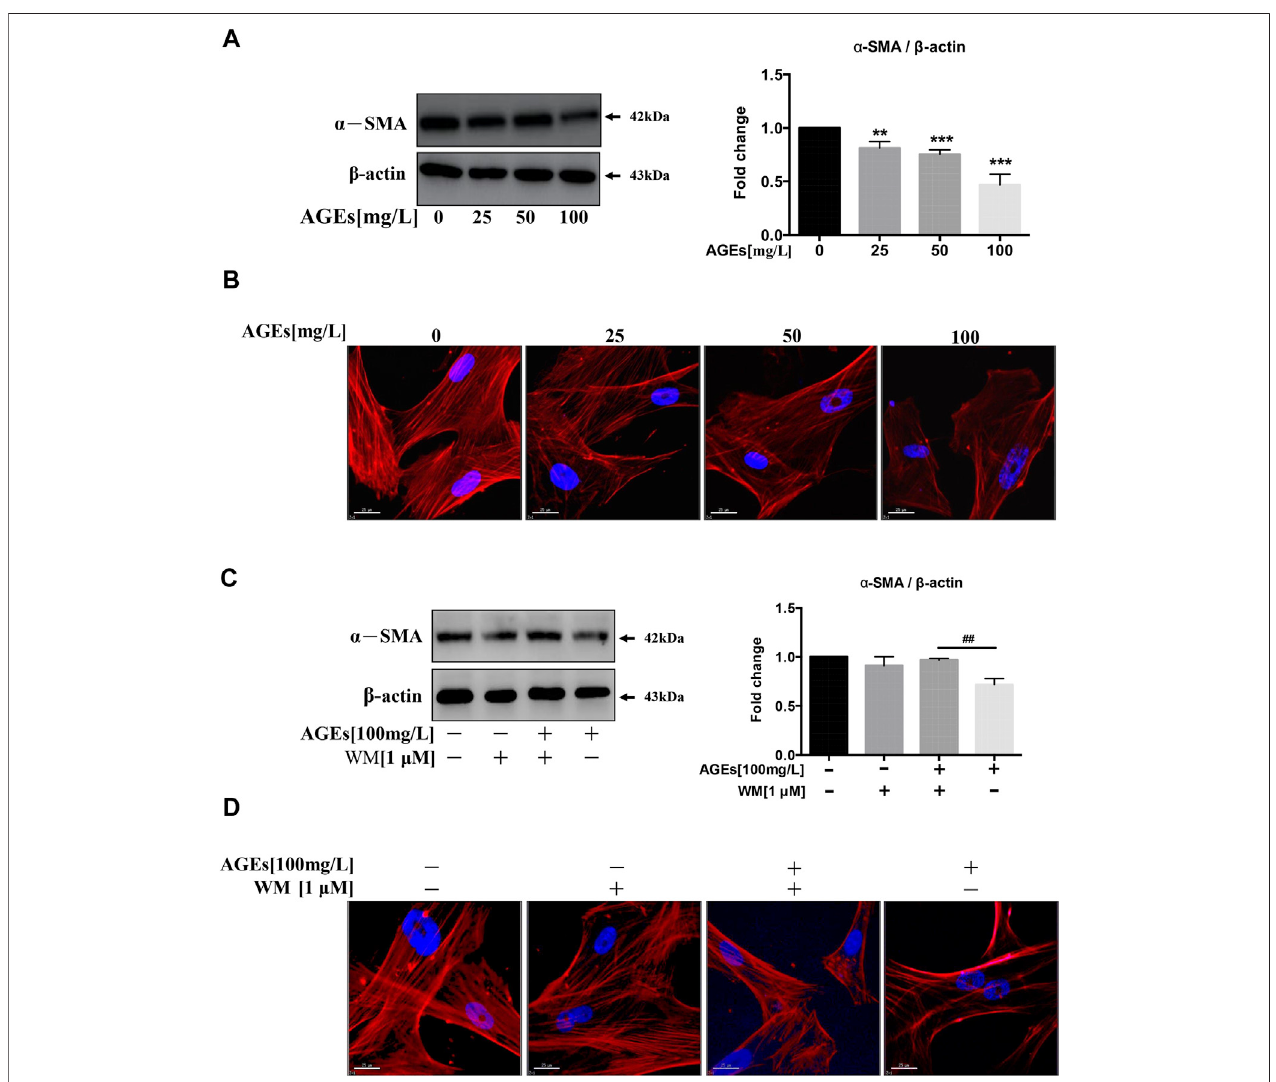
FIGURE5| WMsuppressesphenotypicswitchinginAGEs-treatedHASMCs.CellsweretreatedwithAGEsfor24 h. (A) Westernblotanalysisof α -SMA(asmooth muscle cell-speci fi cprotein). (B) Observation ofthecellcytoskeletoninHASMCsafter treatment withAGEs (0 – 100 mg/L) (red represents F-actin,blue represents DAPI; scale bar (cid:2) 25 μ m). (C) Western blot analysis shows the levels of α -SMA after WM administration (1 µM) in HASMCs. (D) Cytoskeletal staining assay veri fi es osteoblast phenotype (red represents F-actin, blue represents DAPI; scale bar (cid:2) 25 μ m). Data are presented as the fold change compared with the control group. Each point represents the mean ± SD ( n (cid:2) 3/group); *p < 0.05, **p < 0.01, ***p < 0.001 compared with the WM/AGEs group; ## p < 0.01.